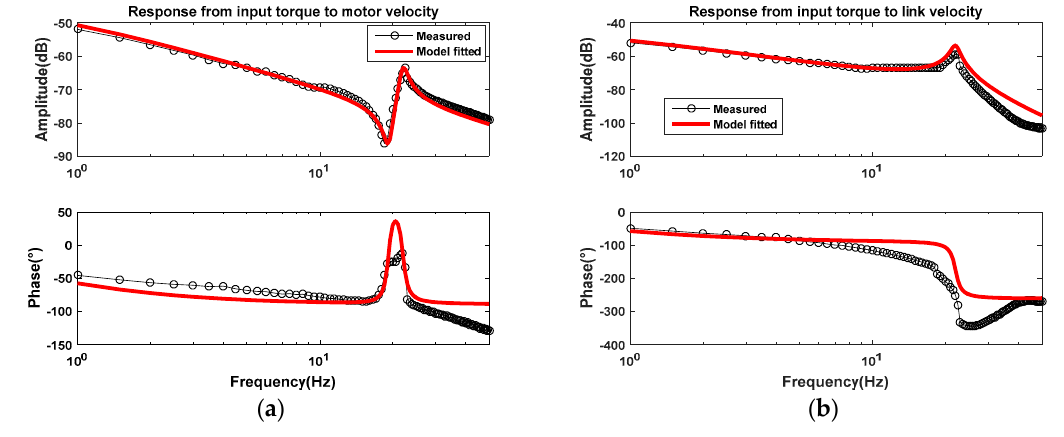
. θ  ; ( b ) from τ to θ m m m ; ( b ) from